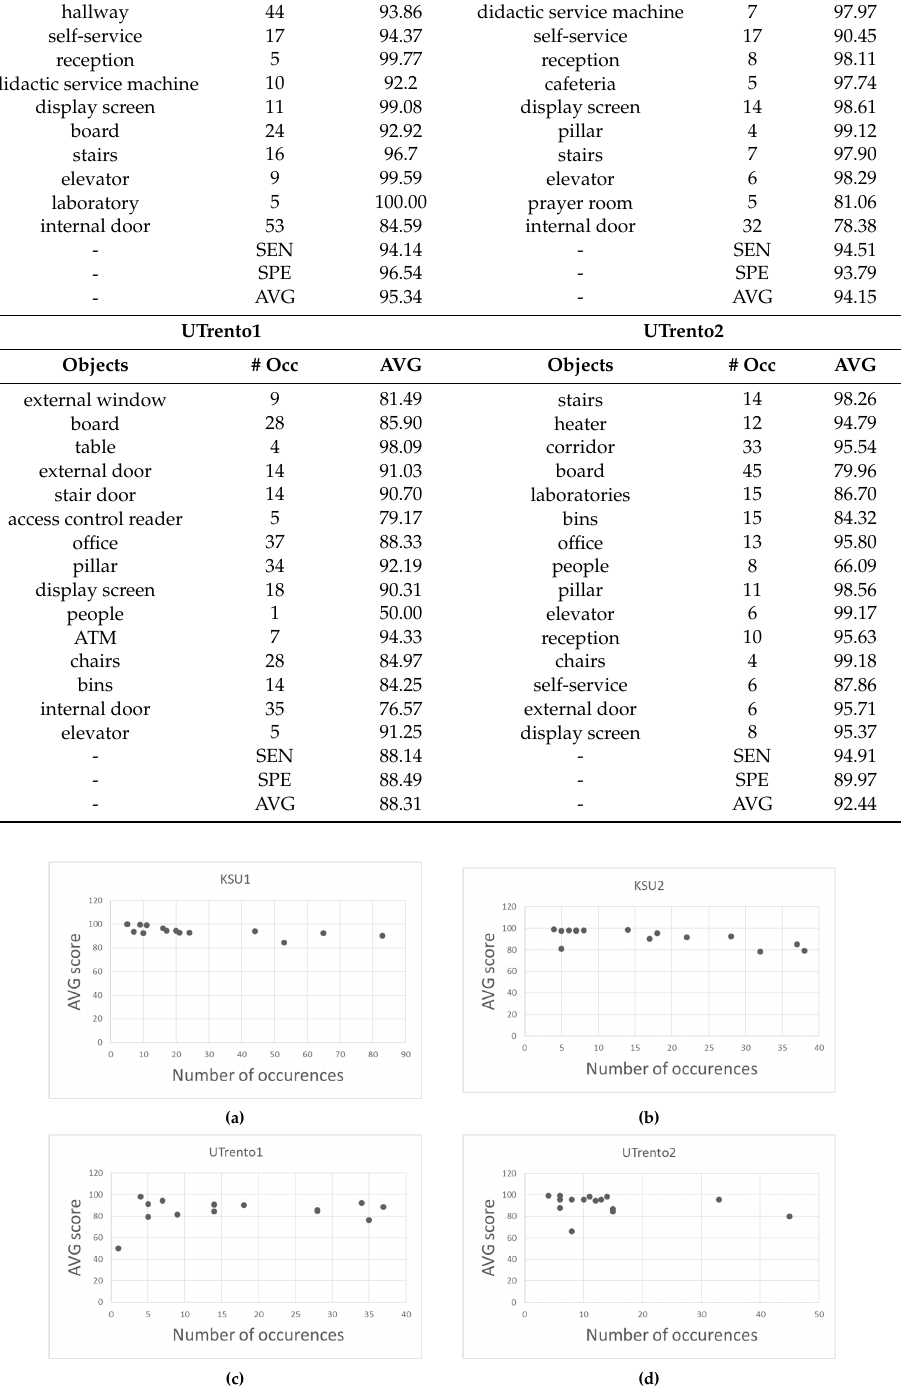
Figure 14. Distribution of objects with respect to AVG score versus the number of occurrences using Model 3: (a) KSU1 dataset, (b) KSU2 dataset, (c) UTrento1, and (d) UTrento2.